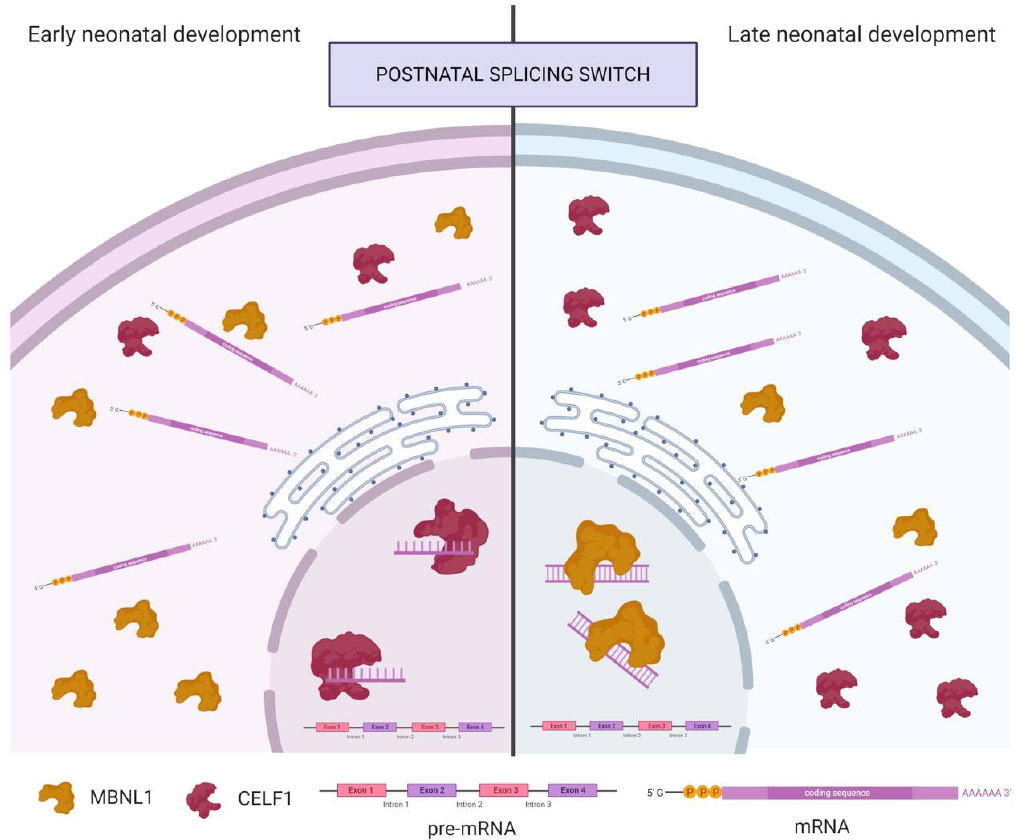
Figure 2. MBNL1 and CELF1 localization in neonatal development in skeletal muscle. CELF1 is the main splicing regulator in the nucleus during early neonatal development. It binds with higher affinity to single-stranded pre-mRNAs that will later pass to the endoplasmic reticulum, where mature mRNAs will be formed. MBNL1 is the main splicing component in the cytoplasm until the postnatal splicing switch when it is translocated to the nucleus, substituting CELF1 in the pre-mRNA binding, although in this case, with higher affinity to double-stranded sequences. Created with Biorender.com.